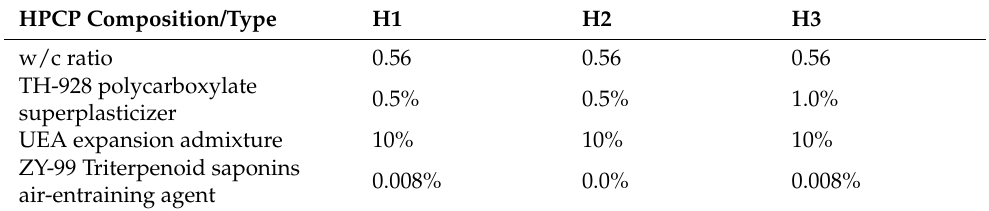
Table 7. Recommended value range for High-Performance Cement Pastes (HPCP) [70].